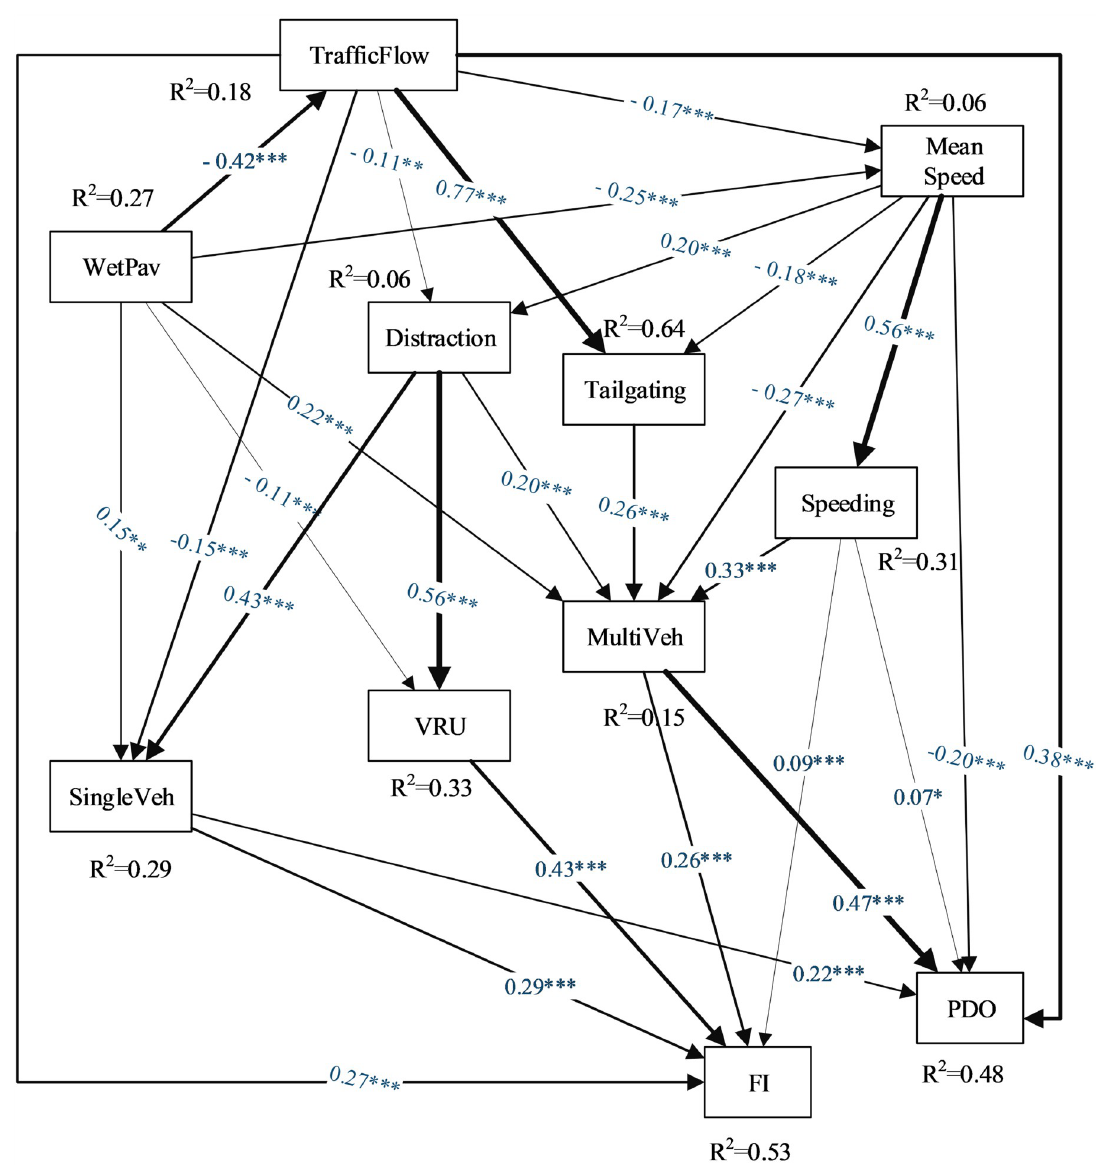
Fig 4. PLS path model results. Note: Values on vectors show standardized path coefficients. FI (Fatal and injury accidents frequency), PDO (Property damage only accidents frequency), SingleVeh (Proportion of Single-vehicle accidents), VRU (Proportion of vulnerable road user involved accidents), MultiVeh (Proportion of multi-vehicle accidents), WetPav (Wet pavement). � p < .05, �� p < .01, ��� p < .001. traffic flow on the road, the higher the prevalence of distracted driving, thus, the higher likeli- hood of single-vehicle accidents. Moreover, wet pavement condition is positively associated with single-vehicle accidents. In line with this finding, research has shown that wet pavement increases the odds of run-off-the-road [75] and rollover accidents [91] due to the lower pave- ment friction. Moreover, wet pavement was negatively related to traffic flow, which, in turn, is inversely associated with single-vehicle accidents. Hence, traffic flow partially mediates the positive association between wet pavement and single-vehicle crashes. Indeed, inclement weather results in decline in unnecessary intercity travel and traffic flow. This, in turn,